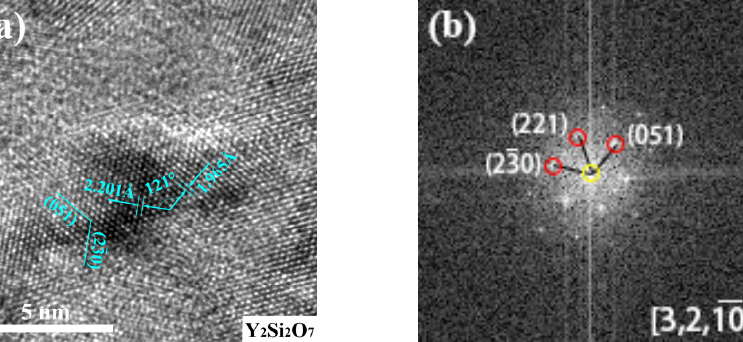
Figure 11. ( a ) HRTEM image of the Y 2 Si 2 O 7 nanoparticle in 1280-S3 ODS steels; ( b ) FFT diagram micrograph by ( a ); ( c ) IFFT filtered image derived from three adjacent diffraction points in ( b ).